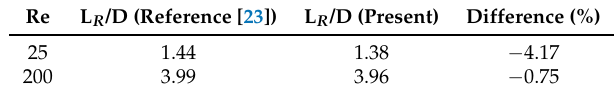
Table 3. Code validation: Recirculation lengths in a right-angled